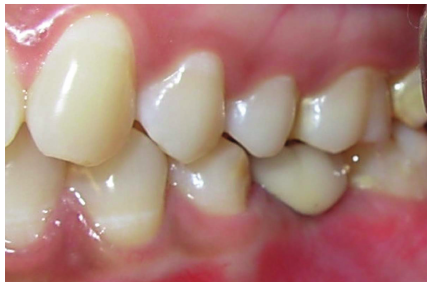
Figure 9: Clinical view of the final restoration at six weeks after surgery.